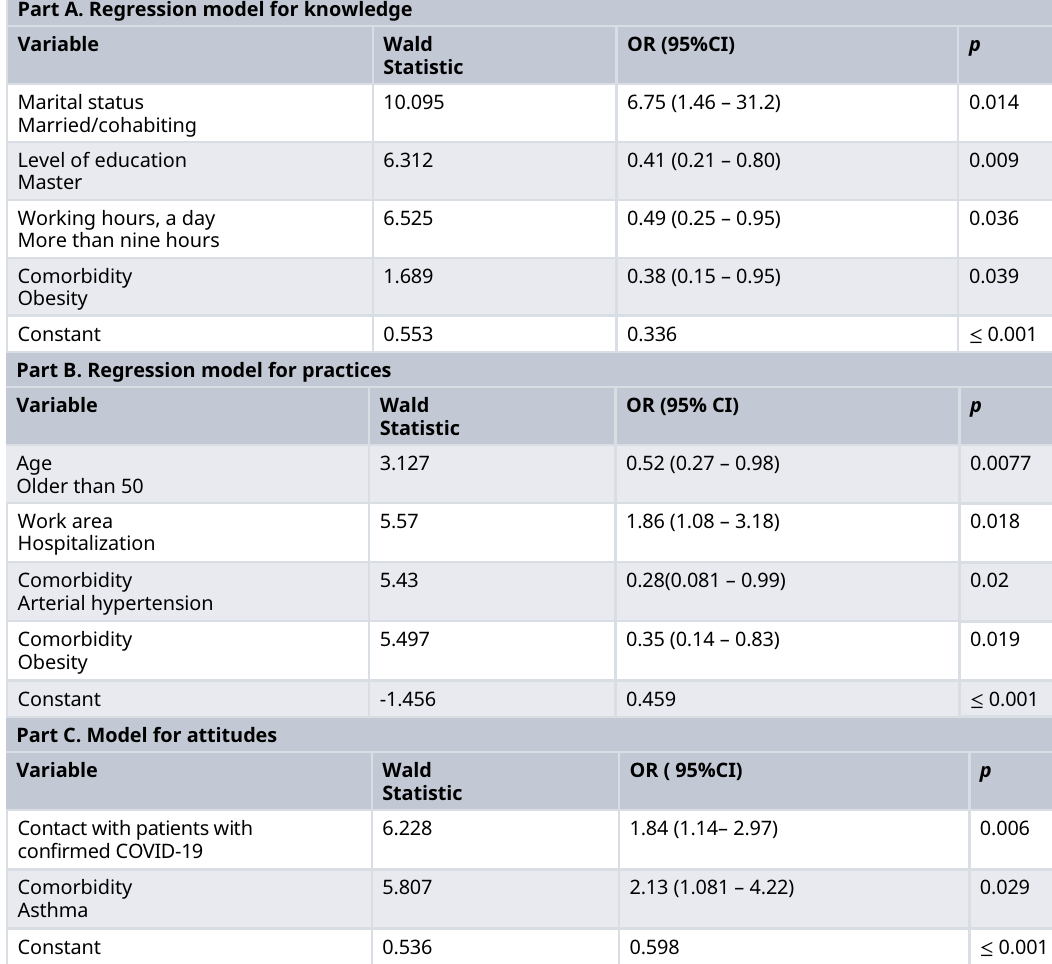
Table 4. Predictors of level of knowledge, preventive practices and negative attitudes towards COVID